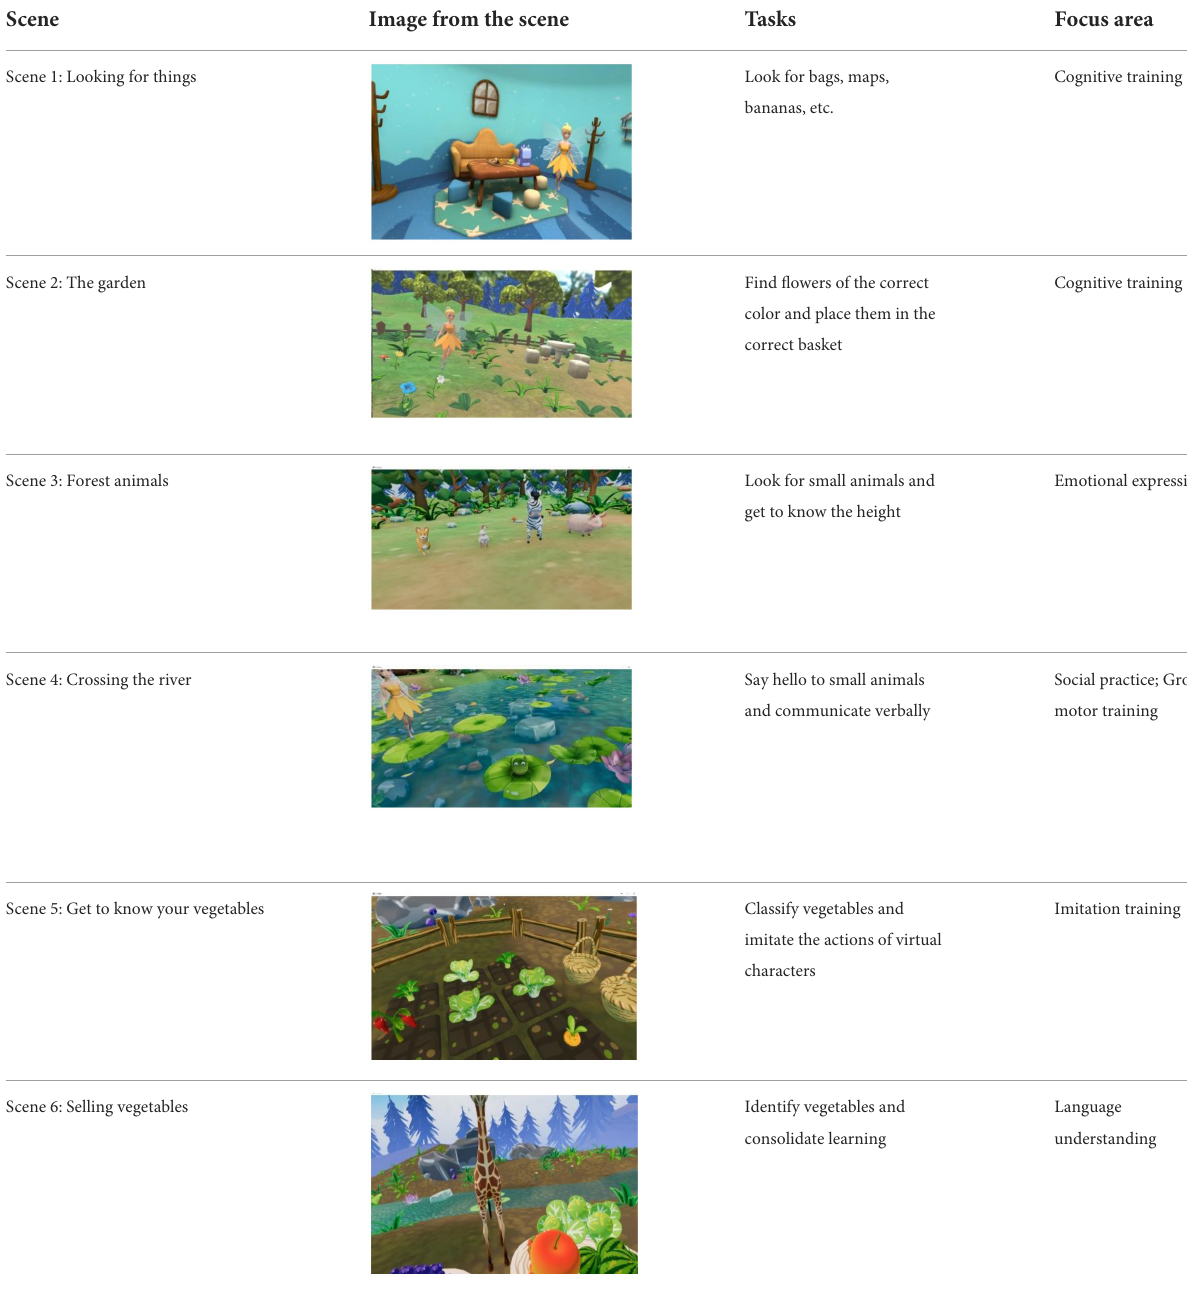
Look for bags, maps, bananas,